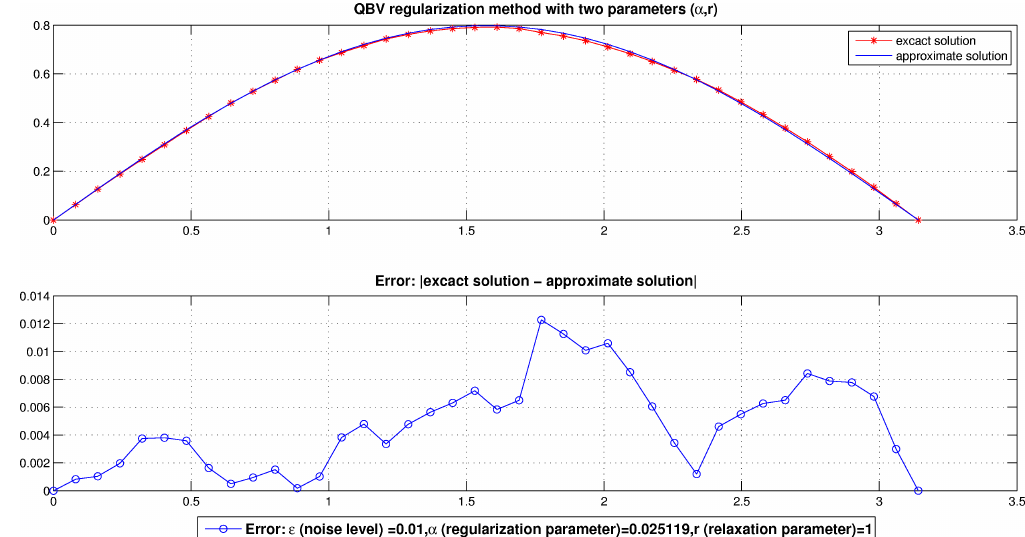
Fig. 6. ε (noise level) =0.01, α (regularization parameter)=0.025119, r (relaxation parameter)=1